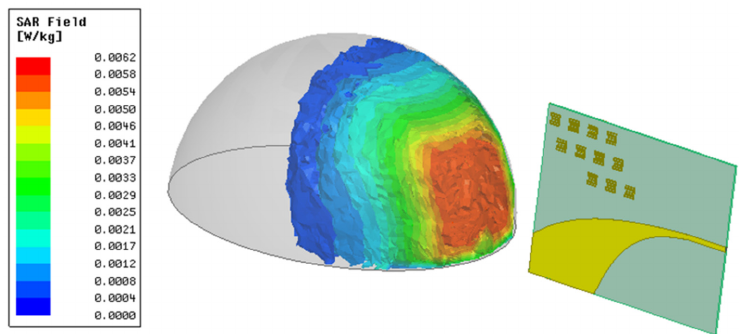
Figure 15. Distribution results of 10 g averaged SAR inside the breast phantom at 5GHz.